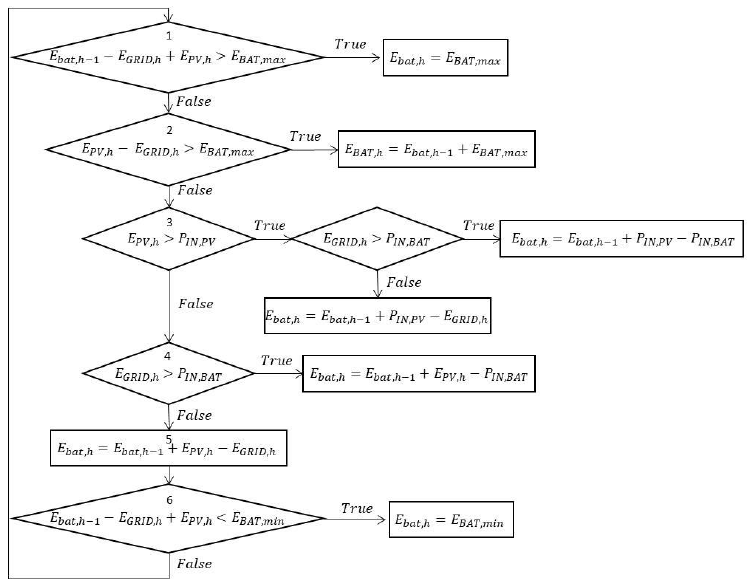
Figure 3. Algorithm for the management of the PV-BESS system.